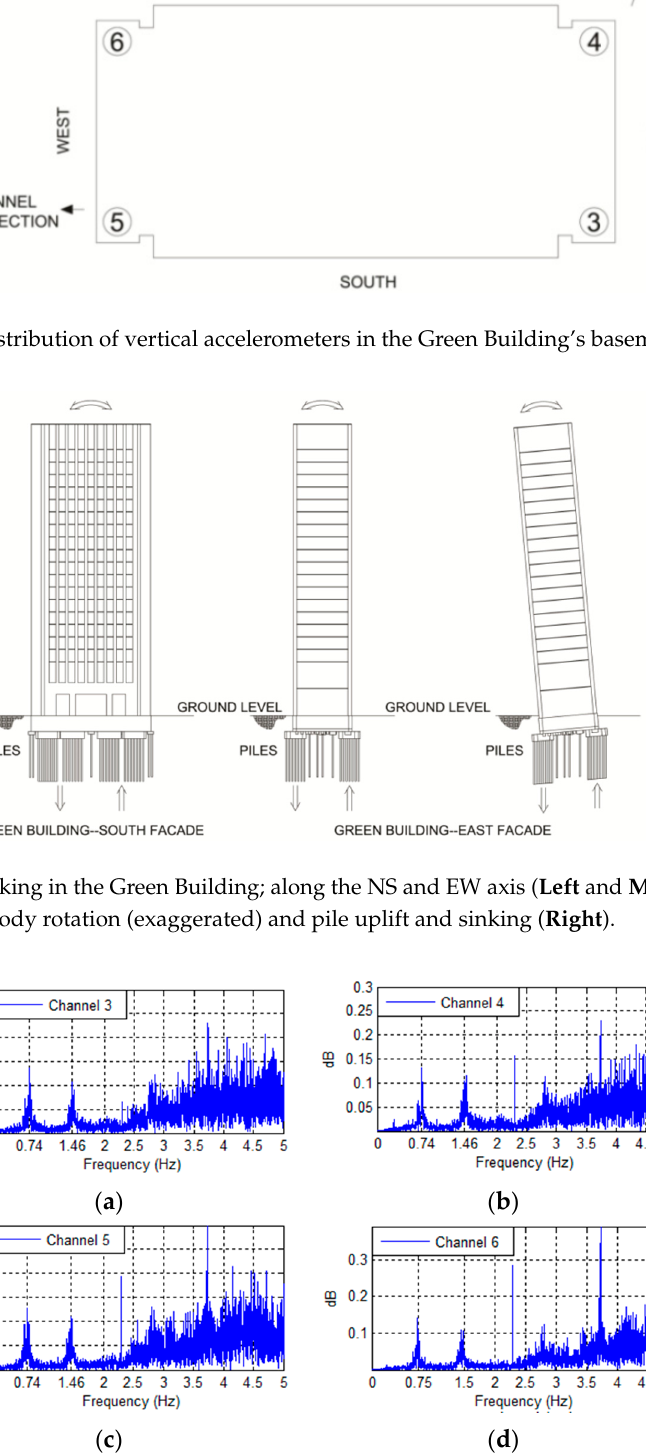
Figure 14. Fourier frequency spectra of the vertical base accelerometers subjected to the 4th of July fireworks show excitation ( a ) Channel 3; ( b ) Channel 4; ( c ) Channel 5; ( d ) Channel 6.